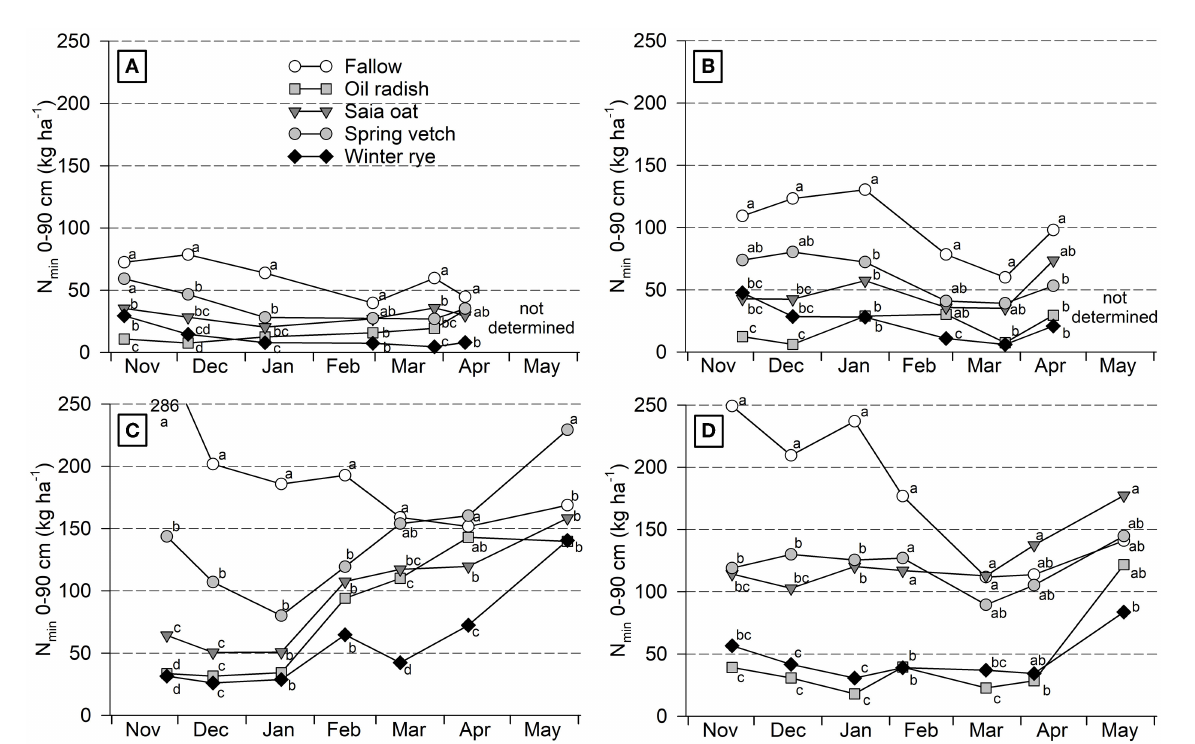
FIGURE1 Course of soil N min over winter and during early growth of unfertilized sugar beet as affected by different cover crop treatments at Ihinger Hof 2018/19 (A) and 2019/20 (B) , and Göttingen 2018/19 (C) and 2019/20 (D) . Mean of 4 replicates. At each site/year combination different letters within one sampling date indicate significant differences at p < 0.05